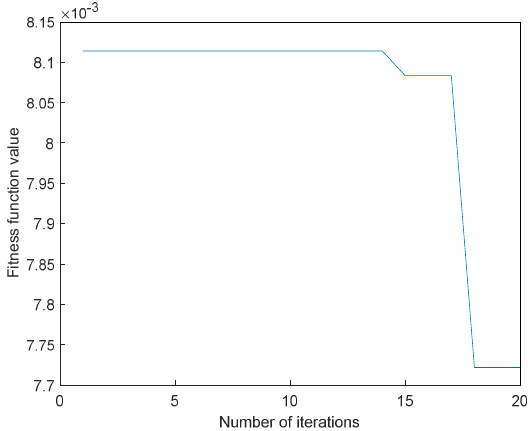
fitness function value changing with the number of iterations is shown in Figure 26.